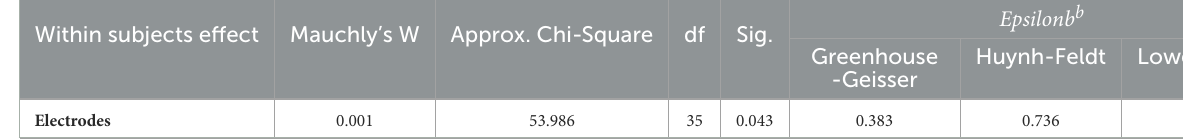
TABLE 1 Mauchly’s test of